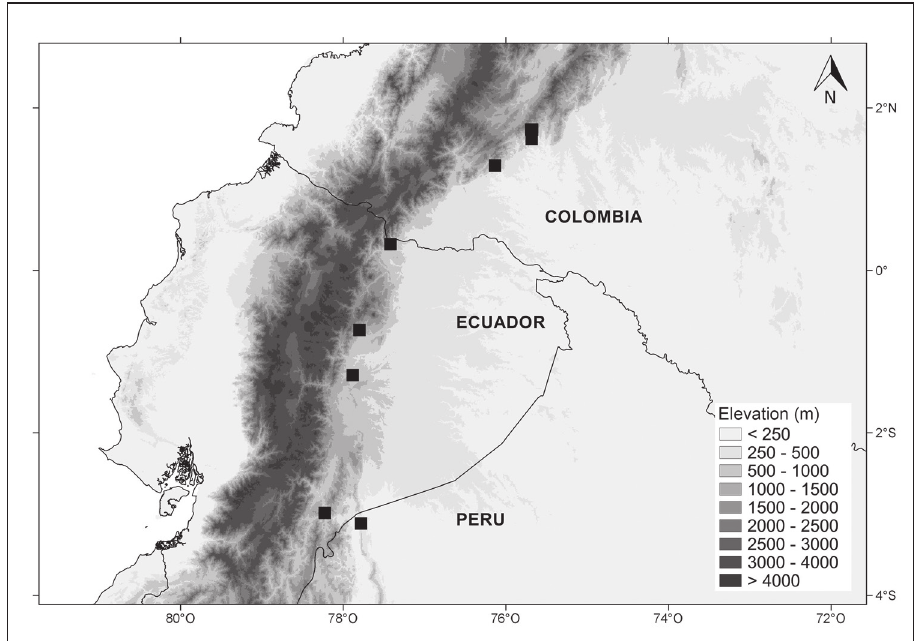
Figure 4. Distribution of Capsicum regale Barboza &